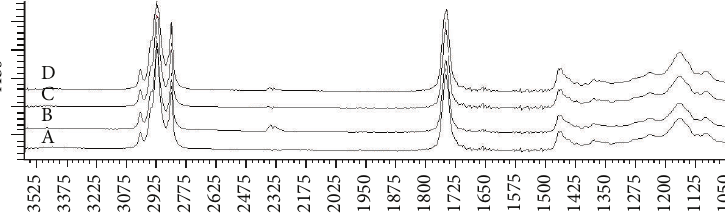
Figure 2: FTIR spectra of the virgin walnut oil (VWO) sample after 0, 6, 8, and 10 days, respectively, under oxidative condition at region of 4000–1030 cm −1 . (A) 0 day. (B) 6 days. (C) 8 days. (D) 10 days.